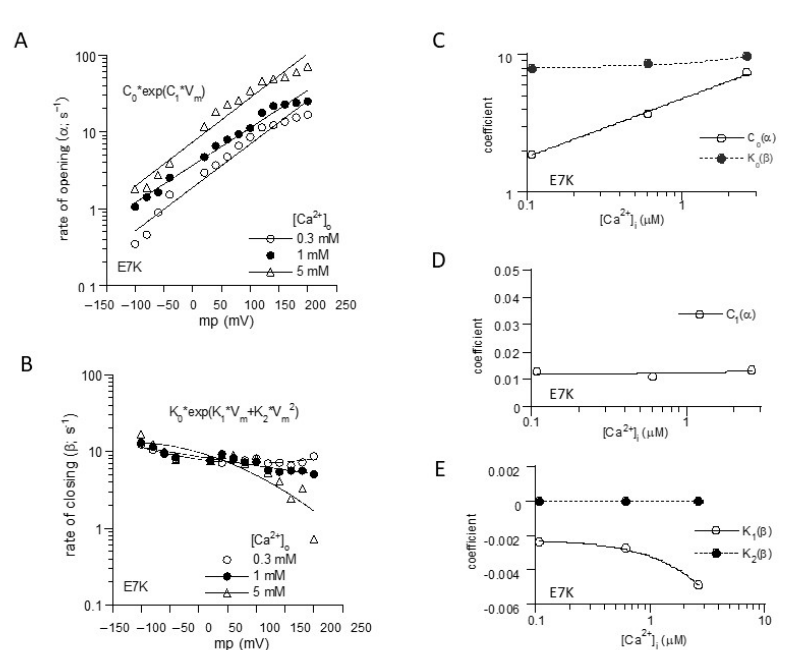
Figure 2. Mathematical formulation of voltage-and Ca 2+ -dependent gating of E7K-TRPM4 channels. ( A ) and ( B ); The voltage-dependencies of α and β were empirically fitted by the exponentials with the first and second-order V m polynominals, respectively. ( C – E ); the coefficients for each polynominal (C 0 , C 1 ; K 0 –K 2 ) obtained in A and B were further empirically fitted with respect to intracellular Ca 2+ concentration ([Ca 2+ ] i ) by linear or exponential fittings. [Ca 2+ ] i was determined by separately preformed [Ca 2+ ] i measurements with the fura-2 digital fluorescence imaging [13]. Reconstructed relationships of P o , α and β versus V m and [Ca 2+ ] i indicate that the E7K mutation renders the channel more readily open at more negative membrane potentials and at lower [Ca 2+ ] i by enhancing the voltage and Ca 2+ dependencies of α and decreasing those of β . In other words, this mutation accelerates the closed-to-open state (C-O) transition and simultaneously decelerates the reverse (O-C) transition of TRPM4 channels via facilitated voltage-dependent gating and increased Ca 2+ -sensitivity (Figure